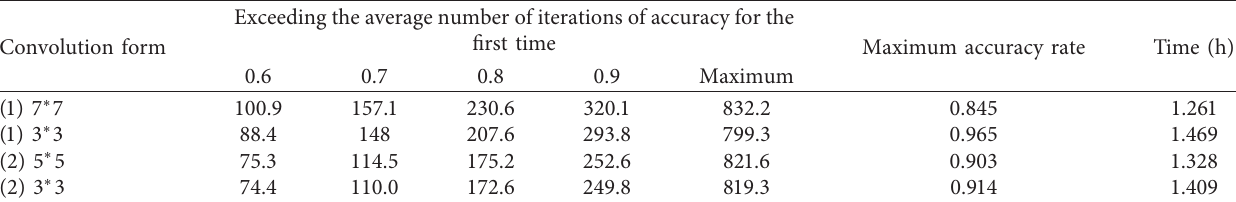
Table 1: Experimental data of small convolution kernel.